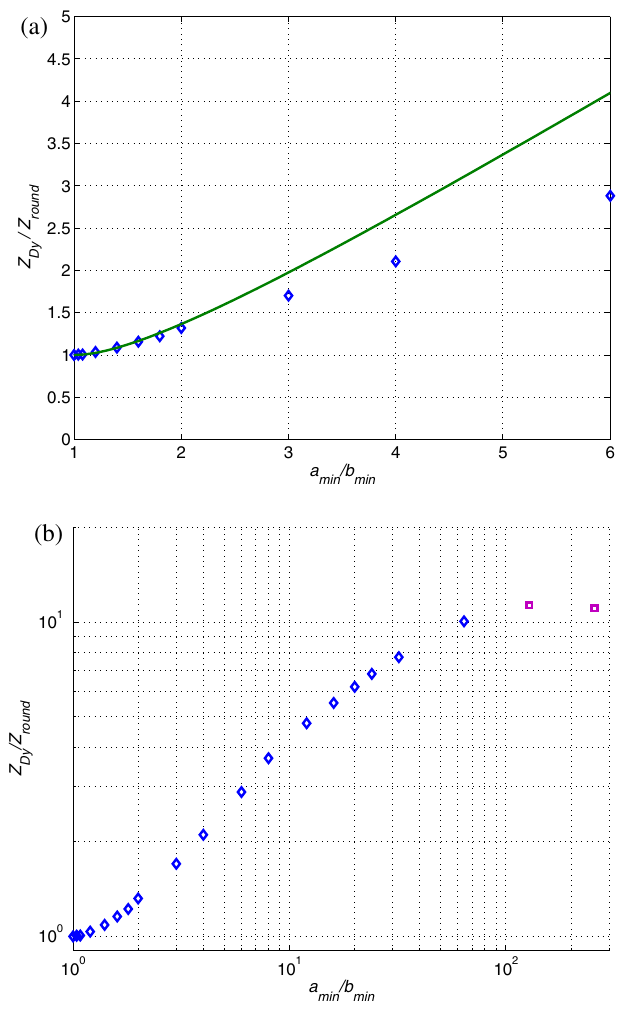
FIG. 12. (Color) Zero-frequency vertical impedance from GDFIDL (symbols) and from the first-order perturbation theory Eq. (3.24) (solid